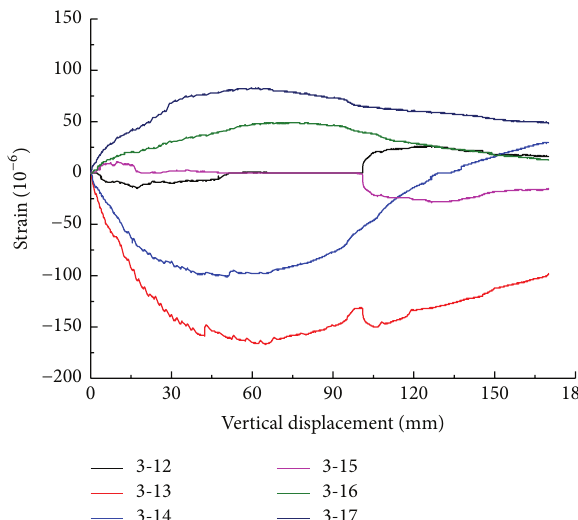
Figure 16: Concrete strain response at the middle of frame column.